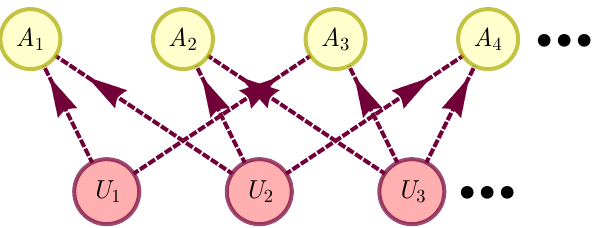
Figure 1: A generic correlation scenario. The independent latent variables U 1 , U 2 ,... influence the observed variables A A . 1 , 2 ,...